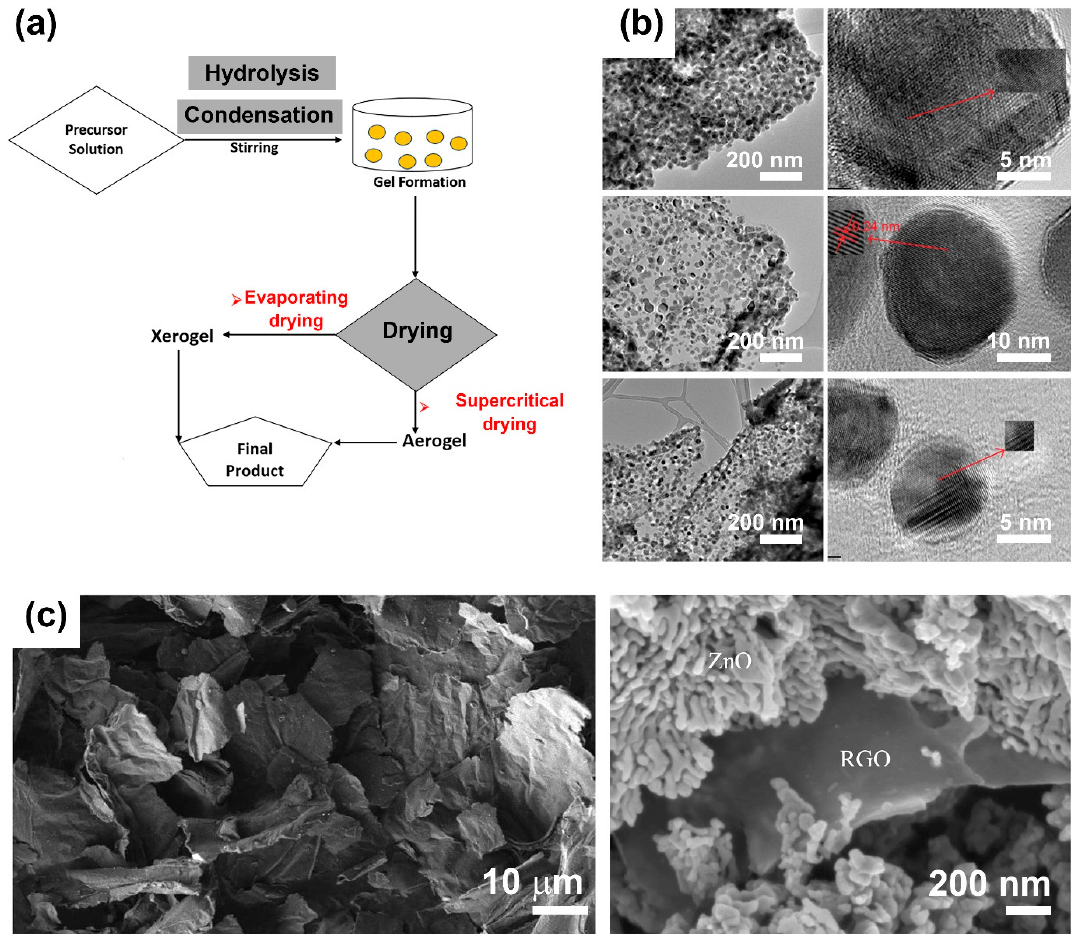
Figure 3. ( a ) Illustration of the sol–gel method, ( b ) transmission electron microscopy images of ZnO–GO nanocomposites (reproduced with permission from ref. [50]; copyright © 2014, American Institute of Physics), and ( c ) scanning electron microscopy of rGO sheets (left) and rGO-ZnO core@shell structures (right) (reproduced with permission from ref. [53]; copyright © 2020, Elsevier).